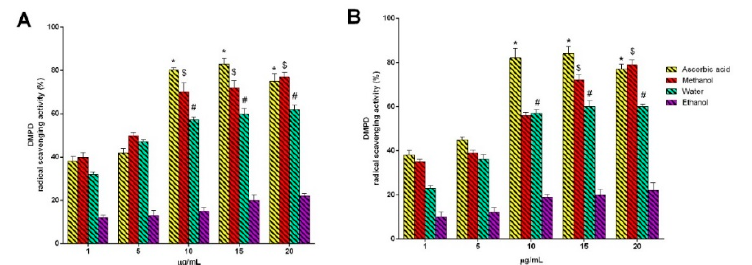
Figure 6. DMPD (N, N ‐ dimethyl ‐ p ‐ phenylenediamine) radical cation decolorization assay: ( A ) Artocarpus heterophyllus Lam. flower extracts, ( B ) Artocarpus lakoocha Roxb. flower extracts. All measurements were performed in triplicate. Data are shown as the mean ± standard deviation, and one ‐ way ANOVA with a Newman–Keuls post ‐ test was used for statistical significance; * p < 0.05 vs. 1 μ g/mL ascorbic acid; $ p < 0.05 vs. 1 μ g/mL methanol extract; # p < 0.05 vs. 1 μ g/mL water